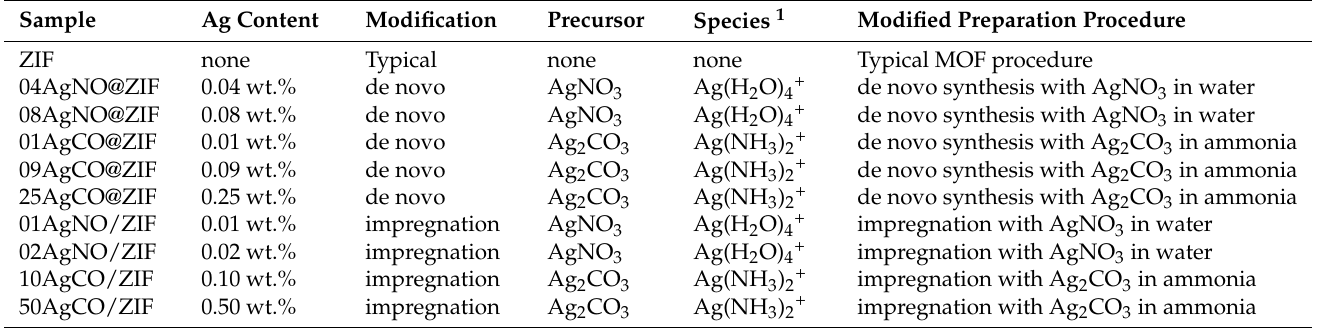
Table 1. Sample preparation by de novo synthesis or impregnation